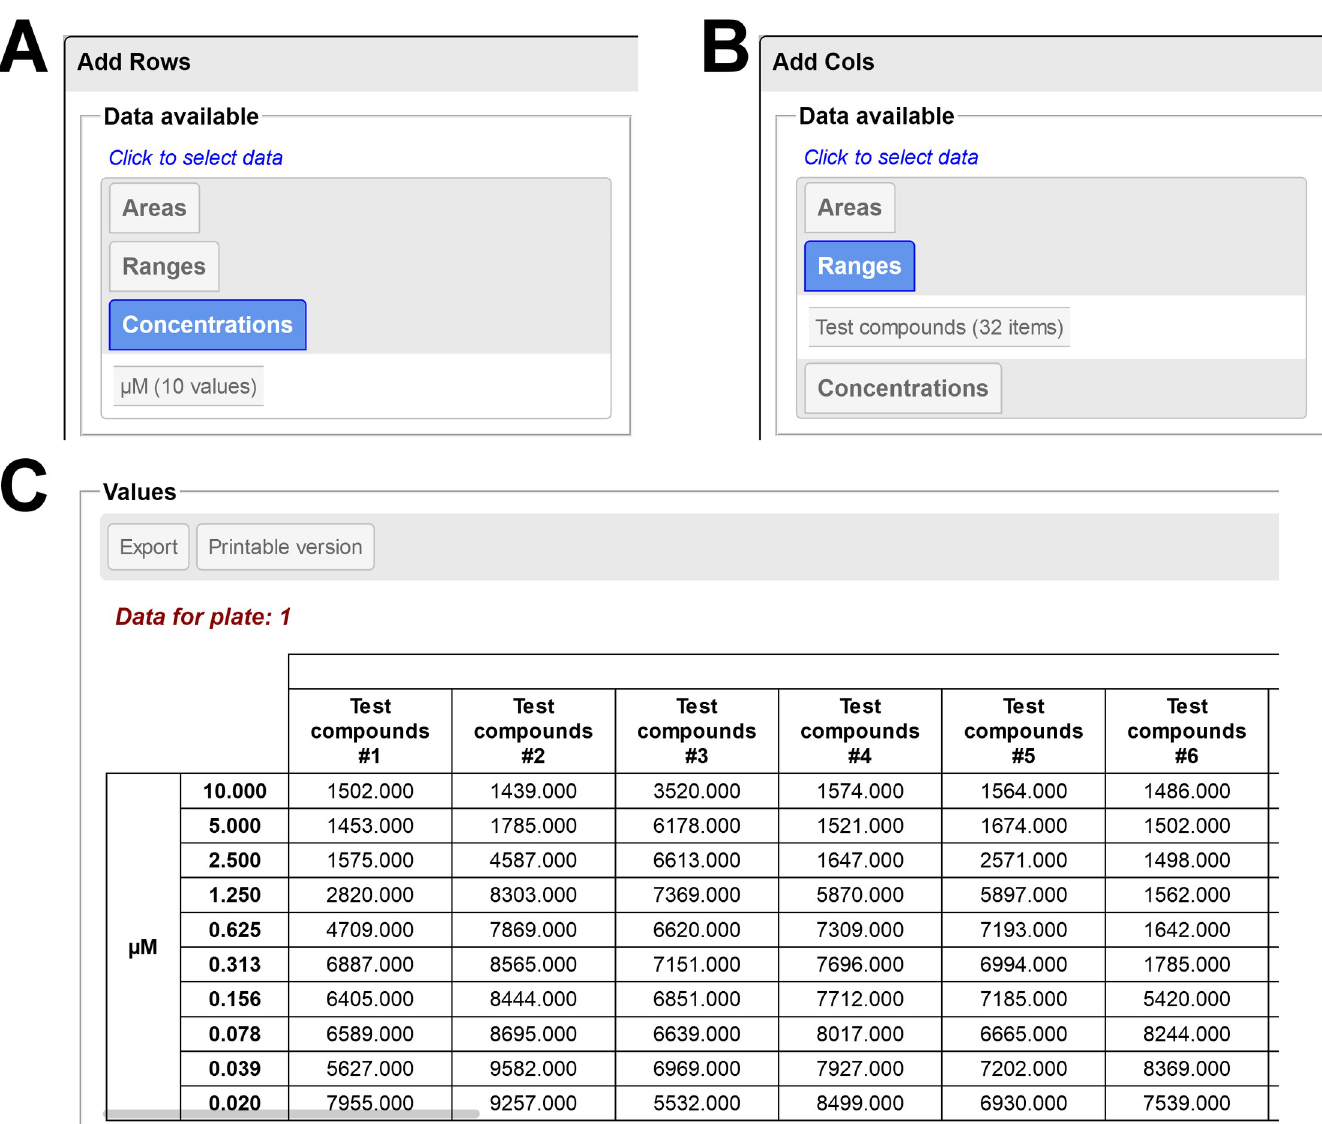
Fig 4. Overview of the Grouped Analysis tool output, for a layout including a range (Test compounds) and multiple concentrations ( μ M) arranged in dose- response. A . For the rows, the concentration series was selected. B . For the columns, the range was selected. C . Resulting two-entry table obtained using configuration as in A and B , with the aggregation mode set on Average (in this mode, only the average value is shown). The table has 32 columns of data but was truncated here for clarity. This figure can be reproduced using the files from the DRC